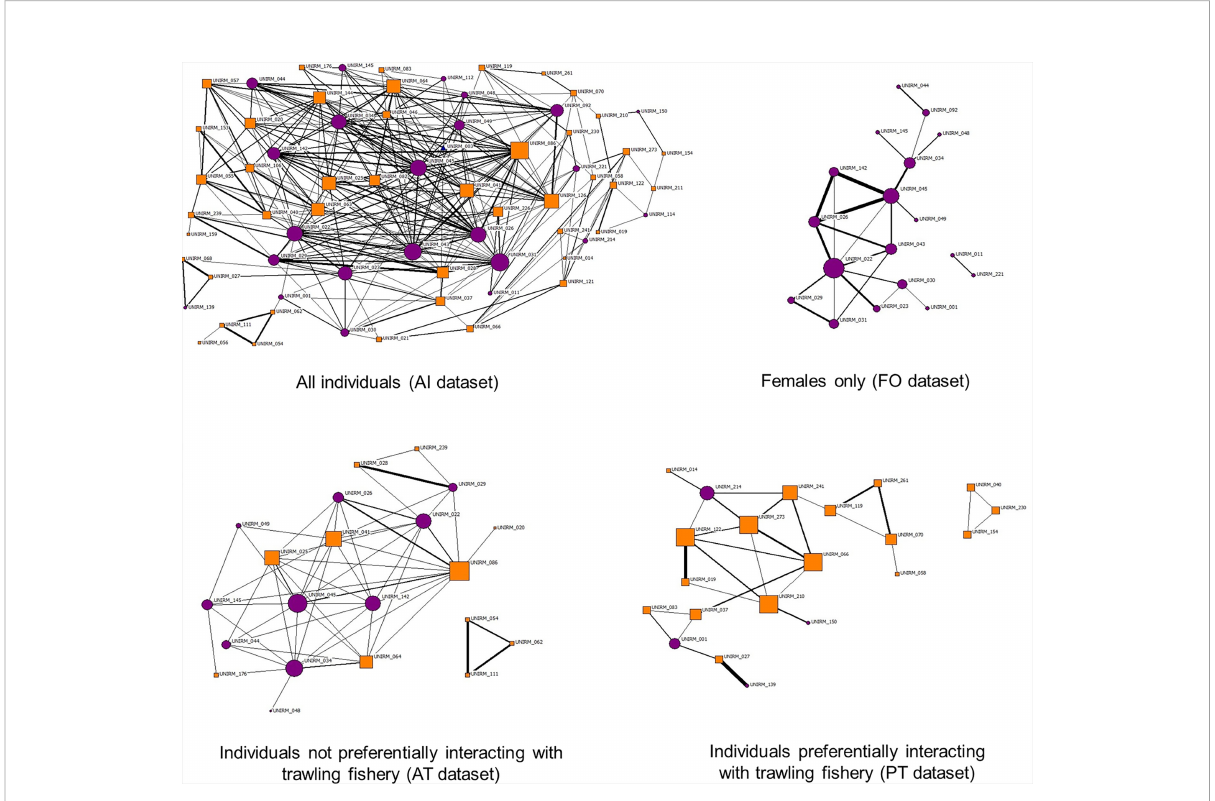
FIGURE 4 Sociograms of individuals in the different datasets. Sociograms were set with HWI values at least twice the HWI ave for all datasets. Top left: sociogram of overall individuals (AI dataset, HWI ≥ 0.36). Top right: sociogram of female individuals (FO dataset, HWI ≥ 0.50). Bottom left: sociogram of individuals not preferentially interacting with trawlers (AT dataset, HWI ≥ 0.50). Bottom right: individuals preferentially interacting with trawlers (PT dataset, HWI ≥ 0.42). Purple circles indicate females, and orange squares mark individuals of unknown gender. HWI, half- weight index.